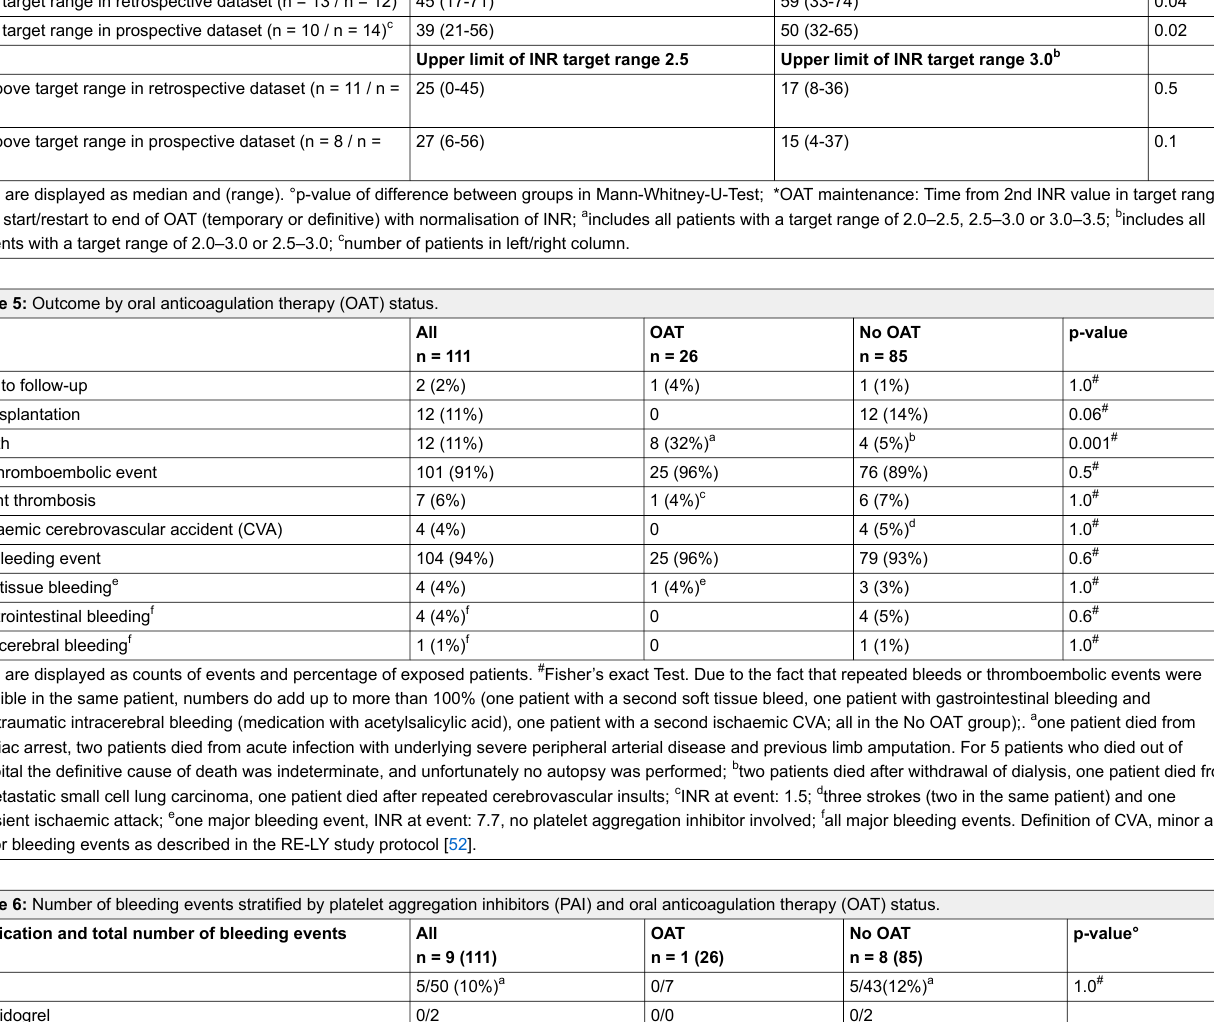
Table 4: INR target range and oral anticoagulation therapy (OAT) control during OAT maintenance*. Width of INR target range 0.5 a Width of INR target range 1.0